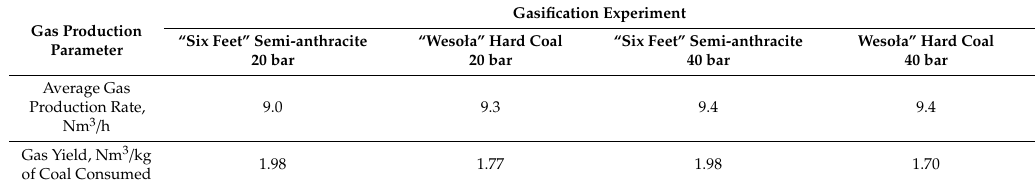
Table 3. Gas production parameters for the UCG experiments conducted.